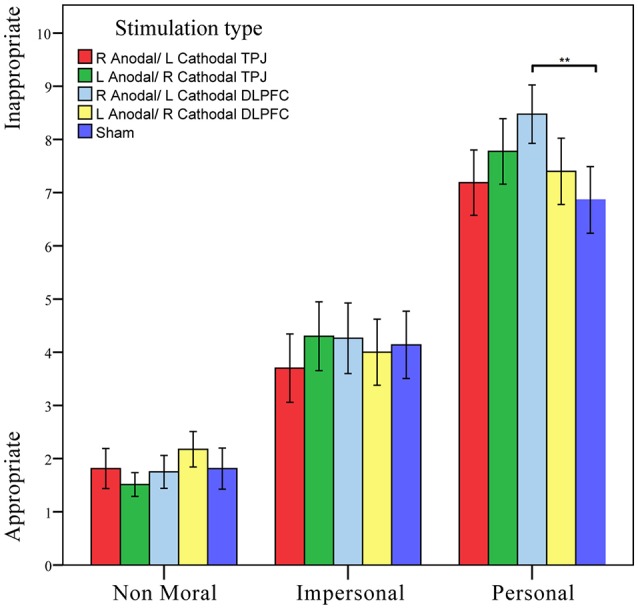
Data of moral response ratings. The moral response ratings of participants with moral-personal, moral-impersonal and non-moral conditions across stimulations. Error bars indicate 95% confidence intervals. Asterisks indicate statistical significance of difference between treatments.